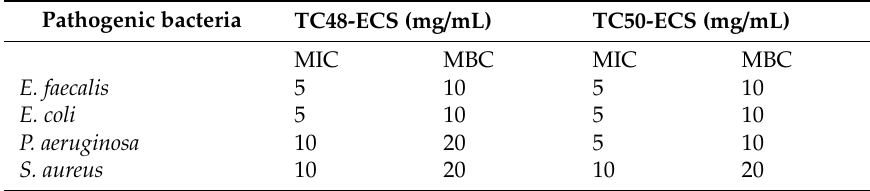
Table 7. MIC and MBC ECS of TC48 and TC50 against different pathogenic bacteria.